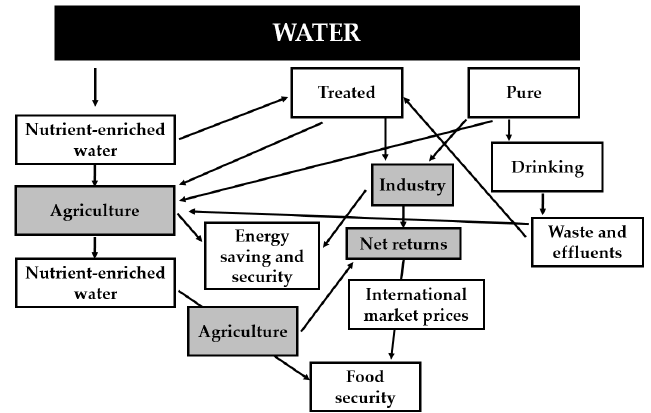
Figure 3. A simplified trade-off framework for eutrophication under the water–energy–food nexus.